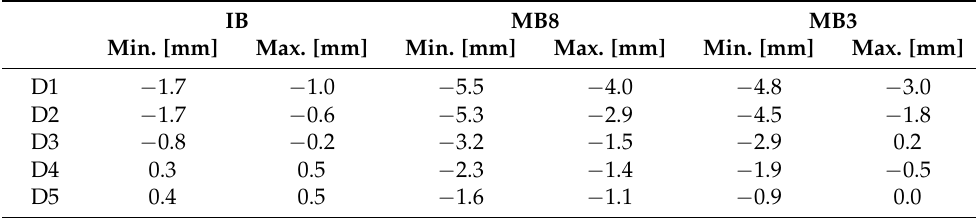
Table 15. Shaft deformation prediction